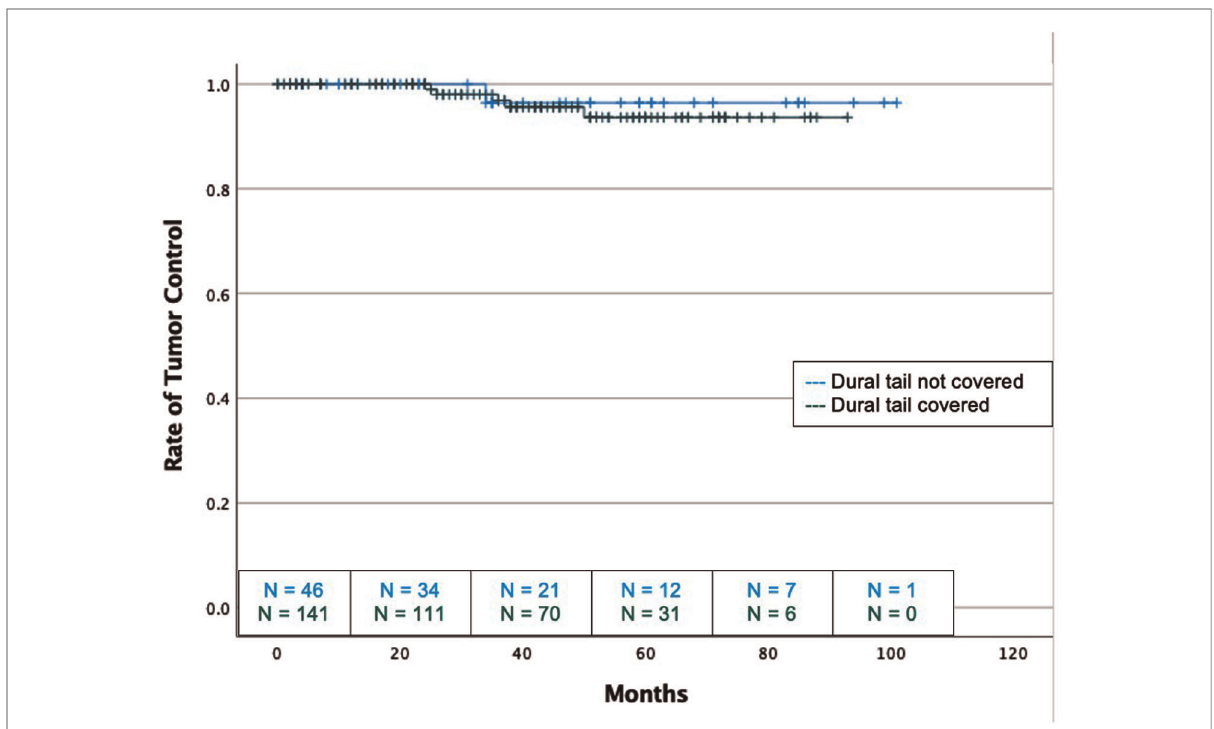
FIGURE 2 Kaplan-Meier graph demonstrating rate of tumor control or dural tail covered and not covered tumors with SRS and FSRT cohorts considered together. Blue: Dural tail not covered, Green: Dural tail covered. Dashes indicate censored patients due loss of follow-up or death. Number of patients remaining without recurrence or loss to follow-up is provided along the x-axis at 20-month intervals (Log Rank P